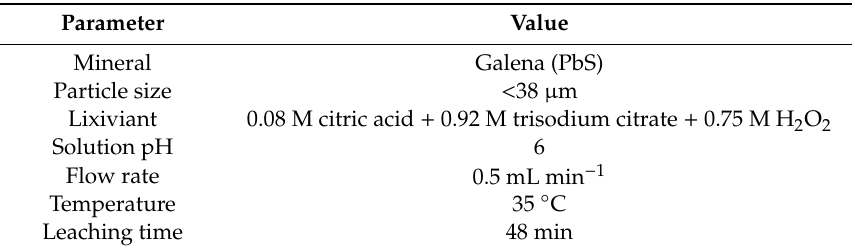
Table 1. Summary of leaching condition.